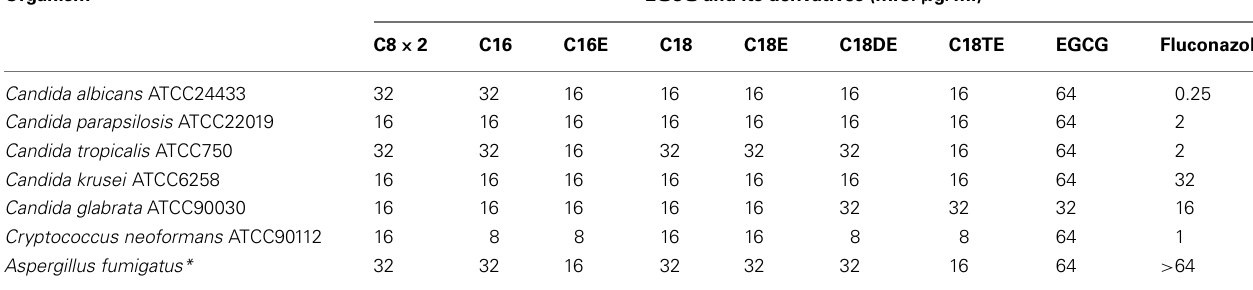
Table 5 |Antifungal activities of EGCG